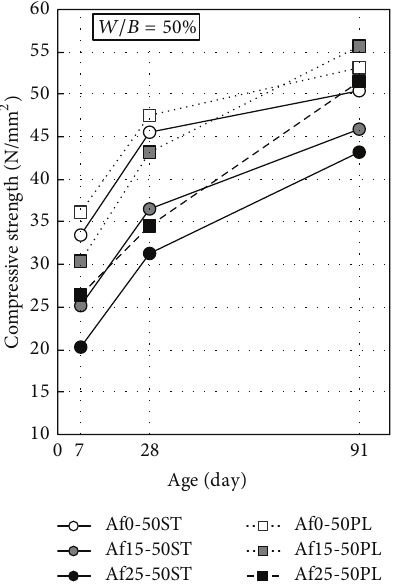
Figure 1: Compressive strength development of concrete (cured in water at 20 ∘